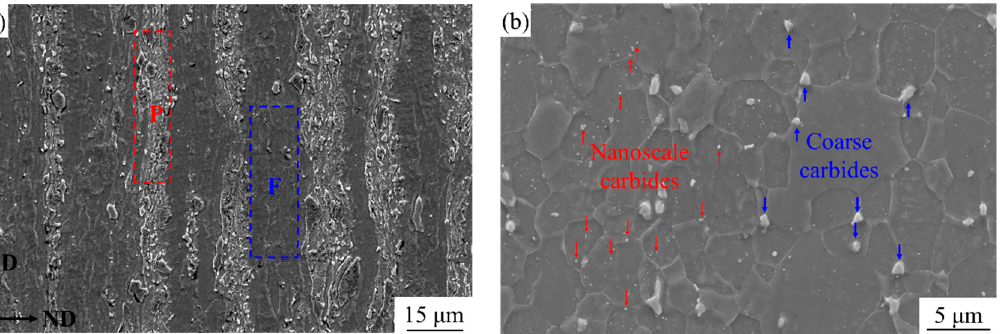
Figure 3. Initial microstructure of LH800 steel: ( a ) cold-rolled state and ( b ) as-supplied state. F: ferrite; P: pearlite; RD: rolling direction; ND: normal direction.